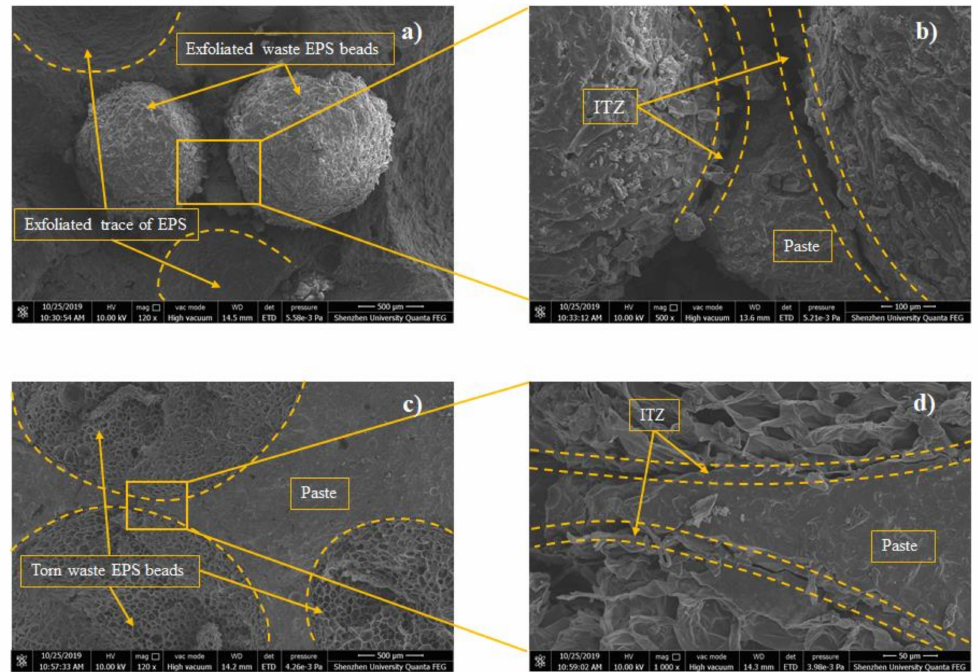
Figure 12. SEM images of microstructure morphology: ( a ) E8 at 120 × , ( b ) E8 at 500 × , ( c ) E8–G4 at 120 × , and ( d ) E8–G4 at 1000 × in 28